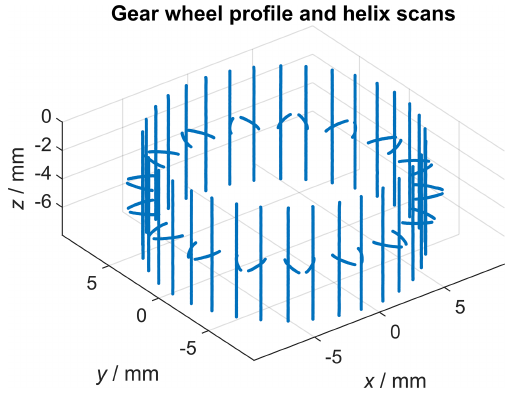
Figure 2. Visualization of a complete tactile gear wheel measure- ment consisting of profile and helix